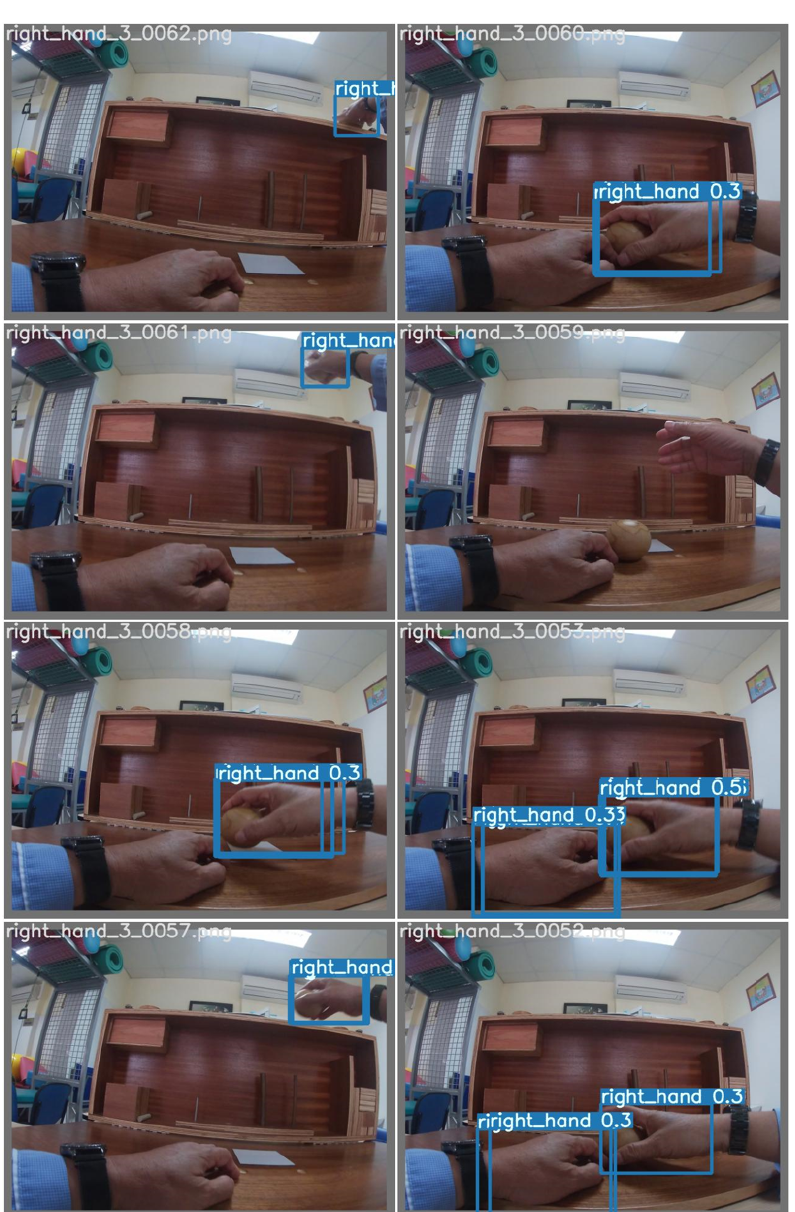
Figure 23. Illustrating the left hand being negatively classified as the right hand of the RehabHand dataset